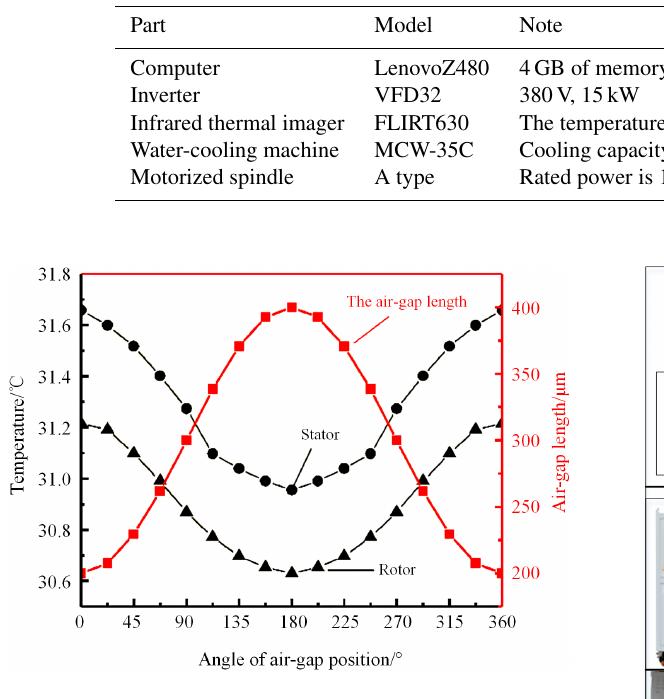
Figure 15. The temperature of the stator and rotor with 100µm eccentricity at different air-gap positions.